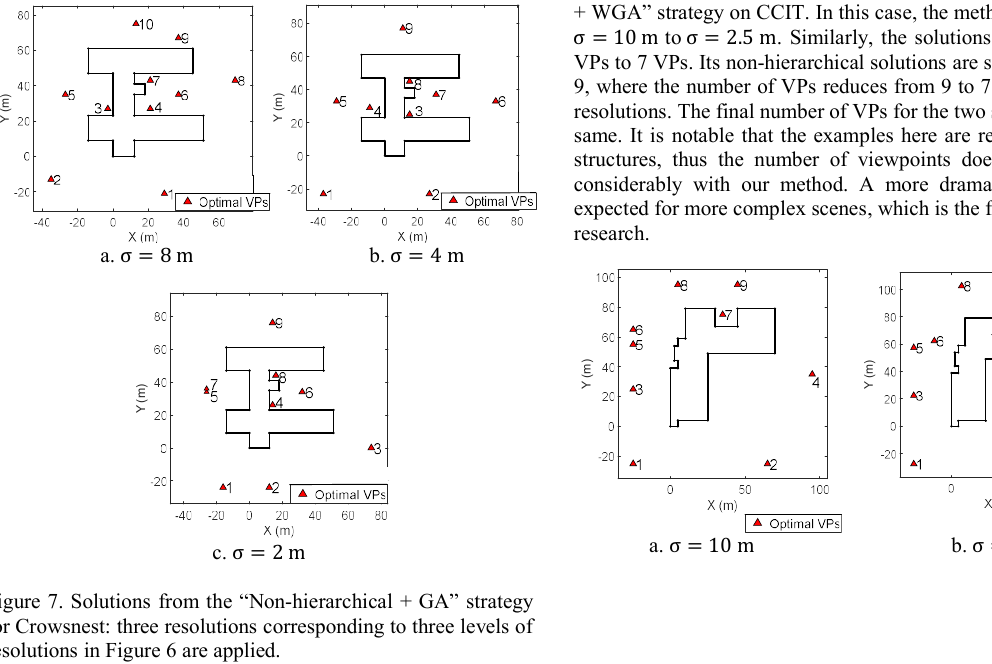
Figure 6. Solutions from the proposed “Hierarchical + WGA” strategy for Crowsnest: three levels of resolutions are applied before the stop criterion is met.